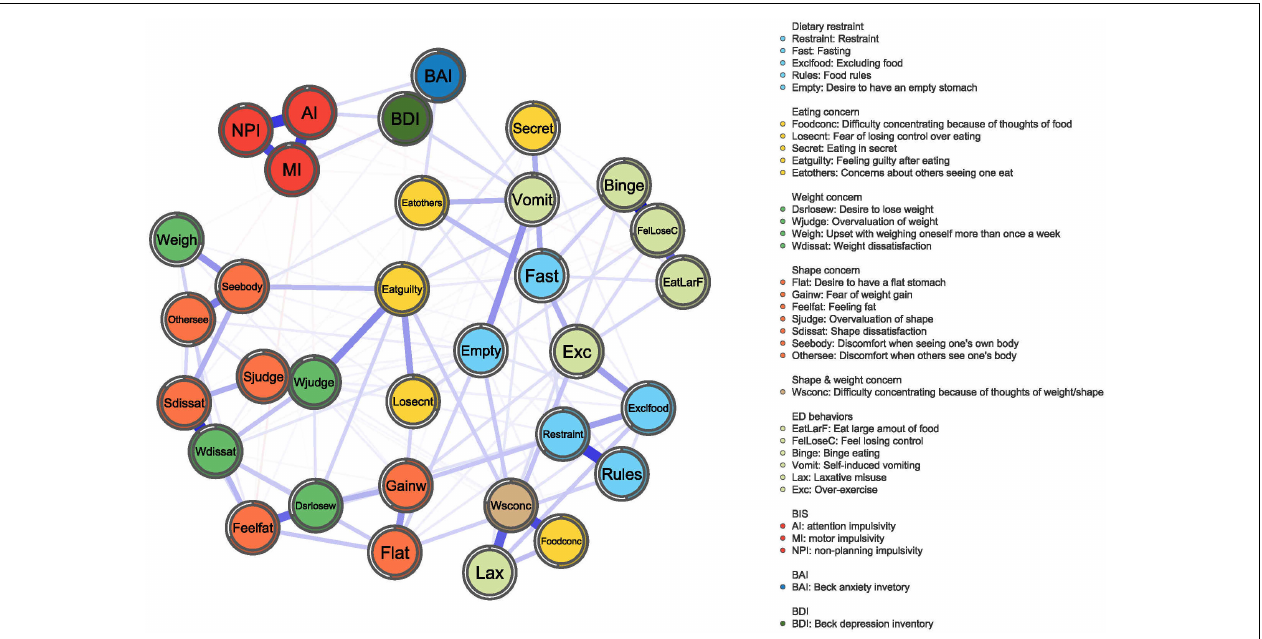
FIGURE 3 | HC network. The network graph shows associations and predictability estimates between ED symptoms (i.e., feel losing control, Shape dissatisfaction, Weight dissatisfaction, Difficulty concentrating because of thoughts of weight/shape), depression symptoms, anxiety symptoms, and impulsivity (i.e., attention impulsiveness, motor impulsiveness, and unplanning impulsiveness) in HC. The edges represent the strength of association between nodes. The different colors of the node indicate the different